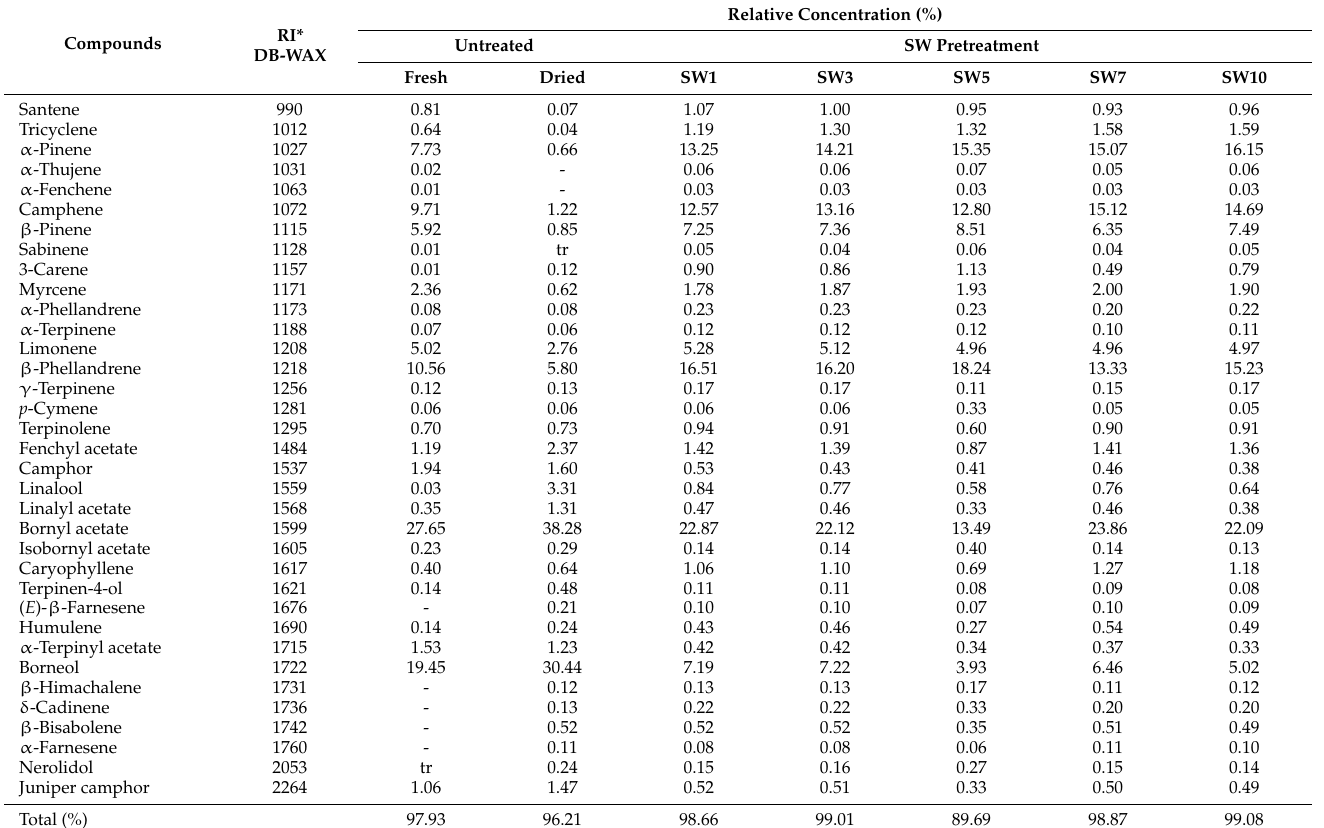
Table 2. Major volatile compounds identified in A. sachalinensis essential